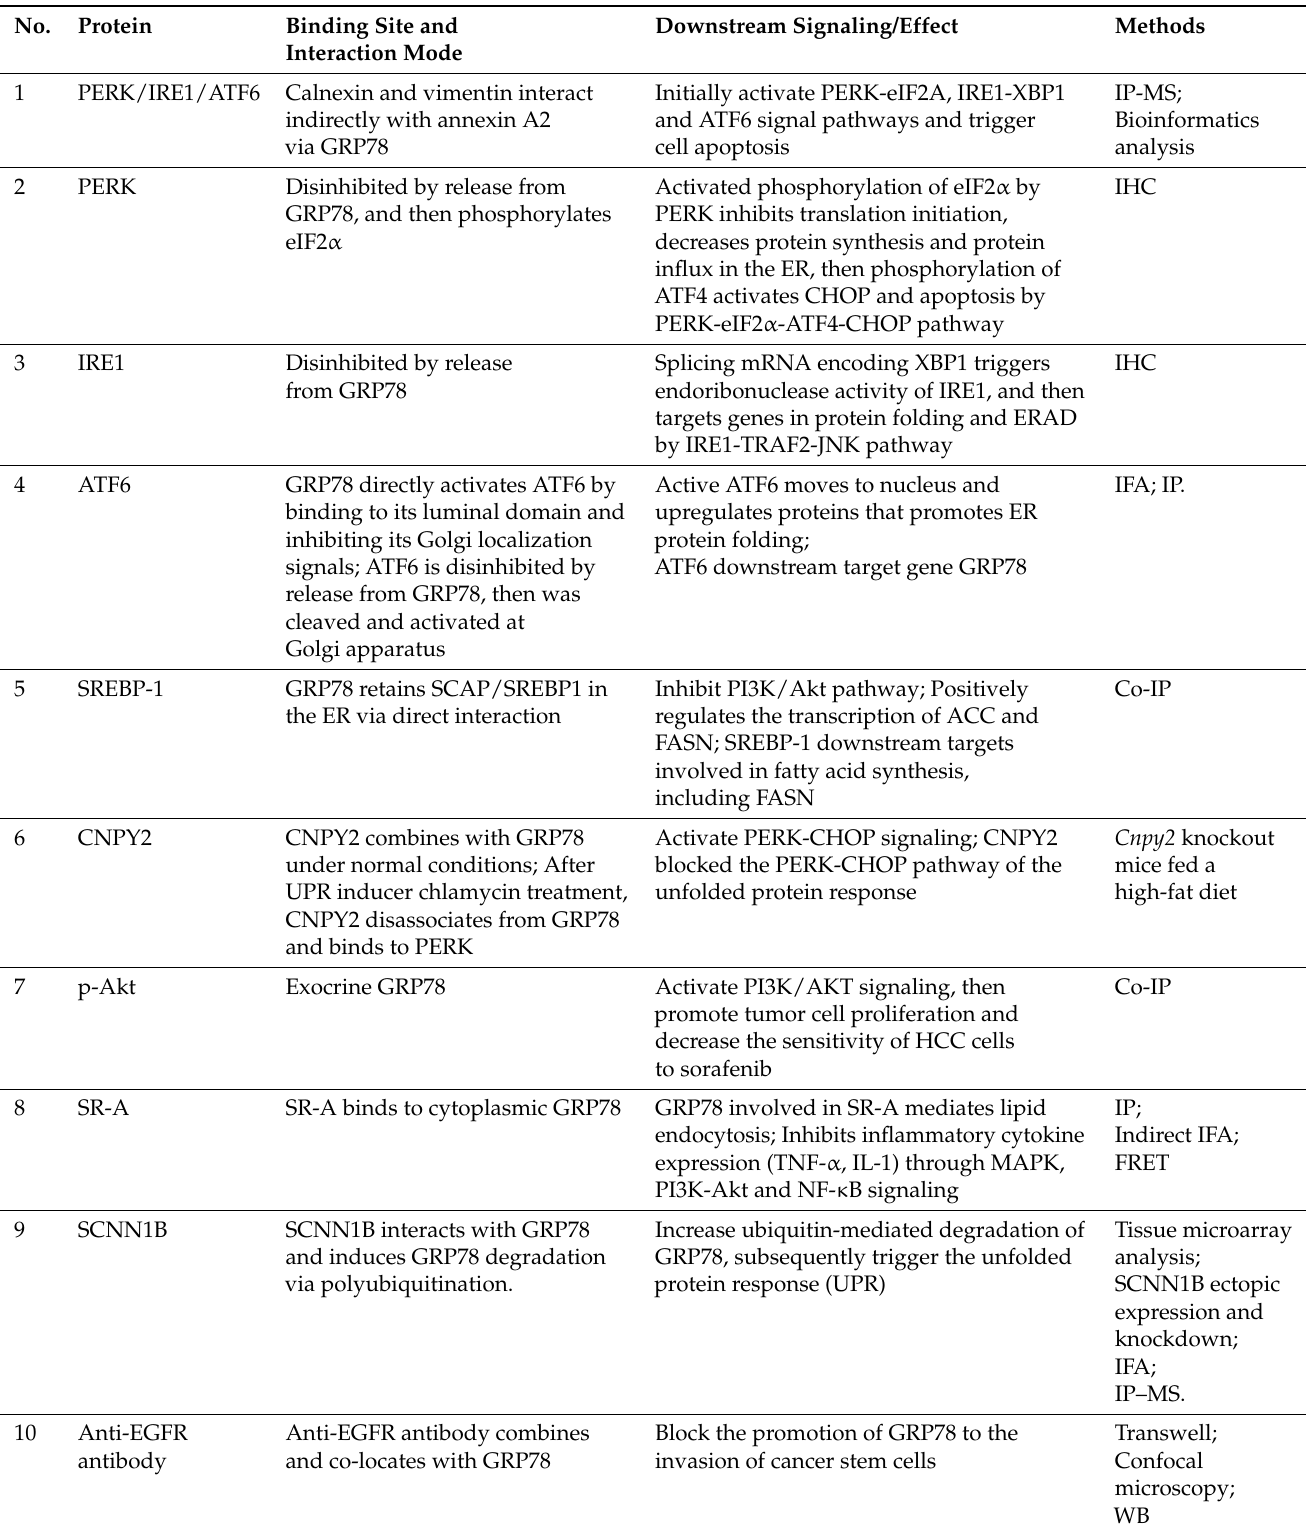
Table 1. List of proteins that directly bind GRP78